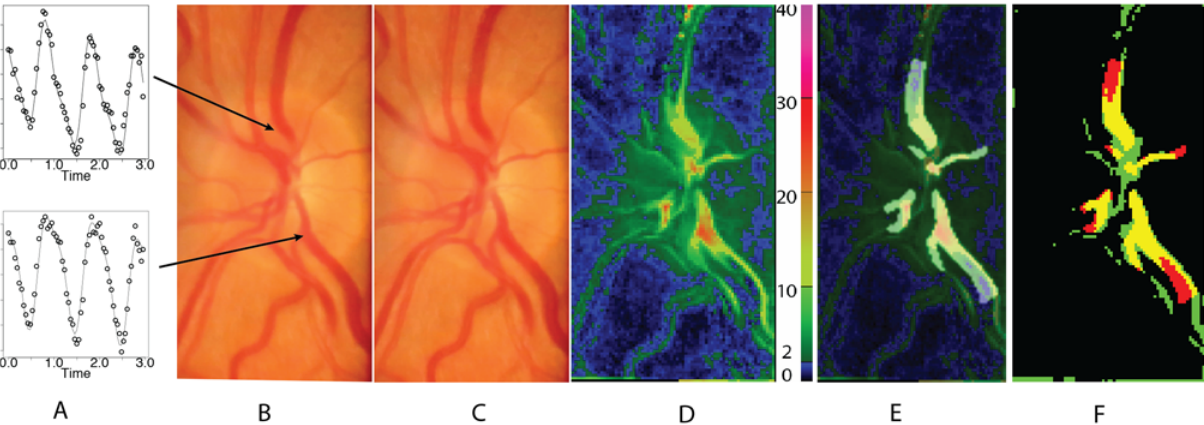
Figure 2. A diagram showing 2 cluster waveforms from different optic disk regions over three cardiac cycles (A) with video frames taken during diastole (B) and systole (C). A heat map with colour scale (D) is shown with observer 1 manual outline of pulsating region overlaid upon the heat map (E). Objective detection (F) with threshold amplitude set at 5 units is shown in yellow where this was in agreement with observer, in green without agreement from observer and in red where the observer noted pulsation but amplitude values were less than 5 units.